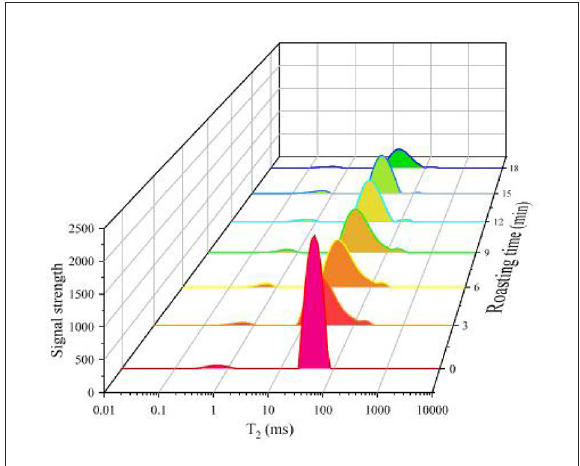
FIGURE4 T 2 relaxation time distribution curve of the roasted beef at the different roasting times.